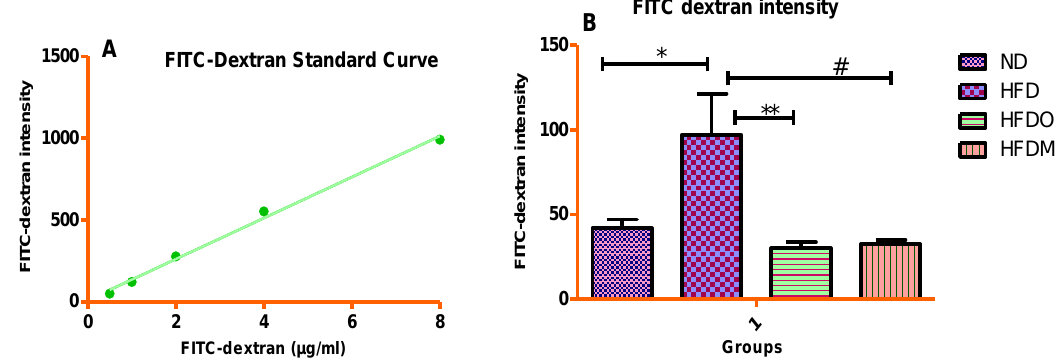
Figure 14. ( A ) FITC-dextran standard curve and ( B ) comparison of intestinal permeability as measured by the FITC-dextran method. Treatment with MESK and Orlistat reduced the intestinal permeability to near normal levels. (* p = 0.0183 between ND and HFD, # p = 0.0101 between HFD and HFDM, ** p = 0.0091 between HFD and HFDO). (ND: normal diet, HFD: high-fat diet, HFDO: HFD + Orlistat, HFDM: HFD + MESK).